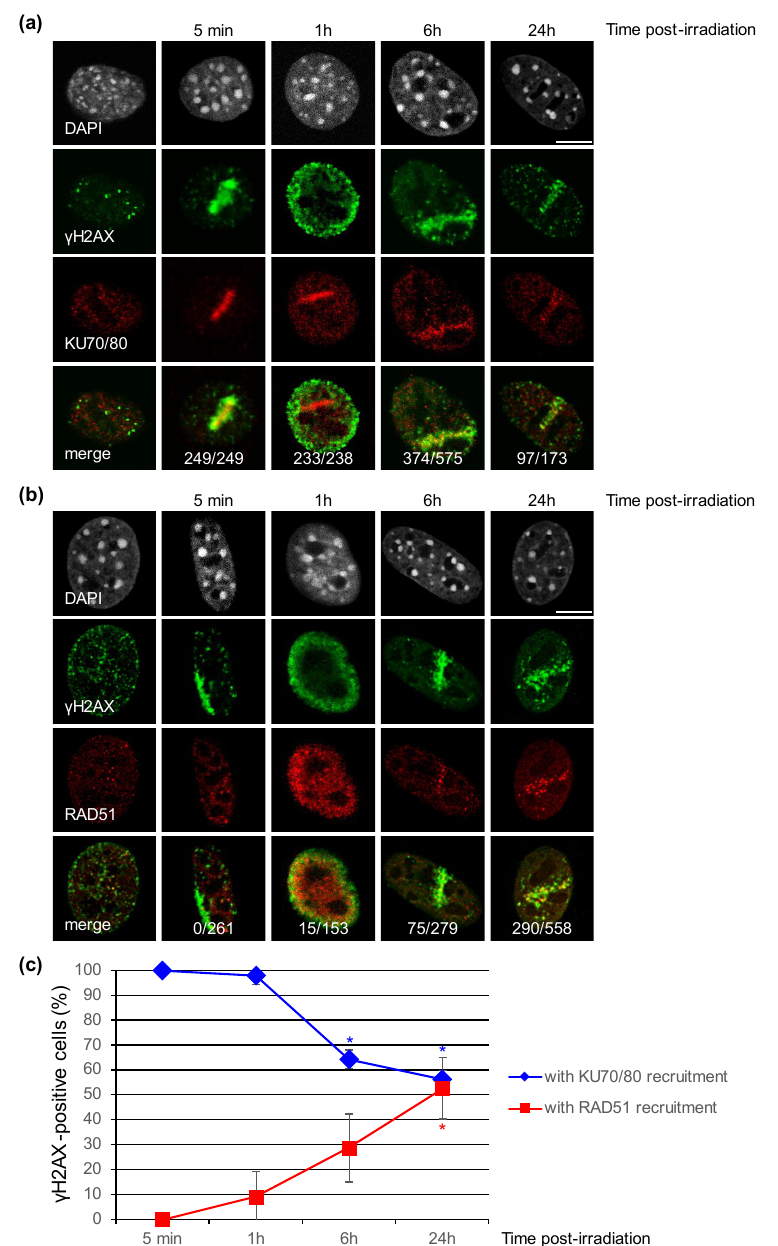
Figure 4. Recruitment of the KU complex or RAD51 to DNA damage sites induced by a microbeam irradiation with α -particles in NIH-3T3 cells. ( a , b ) Accumulation of the KU complex and RAD51 proteins to DNA damage sites detected by γ H2AX staining at the indicated time upon irradiation. The samples used in Figure 2 were subjected to co-immunostaining with antibodies against γ H2AX and KU70/KU80 ( a ) or RAD51 ( b ). In the non-irradiated cell panels, a representative cell displaying KU70/80 staining ( a ) and a cell in S phase with RAD51 staining ( b ) are shown. DNA was stained with DAPI. The total number of γ -H2AX-positive cells carrying KU70/80 signal or RAD51 signal is indicated for each time point. Bars represent 10 µm. ( c ) Percentage of γH2AX -positive cells with KU70/80 signal or with RAD51 signal. Each value shown represents the mean of at least two independent experiments from ( a , b ). Error bars represent the standard error, and the p values are indicated (* p < 0.05).